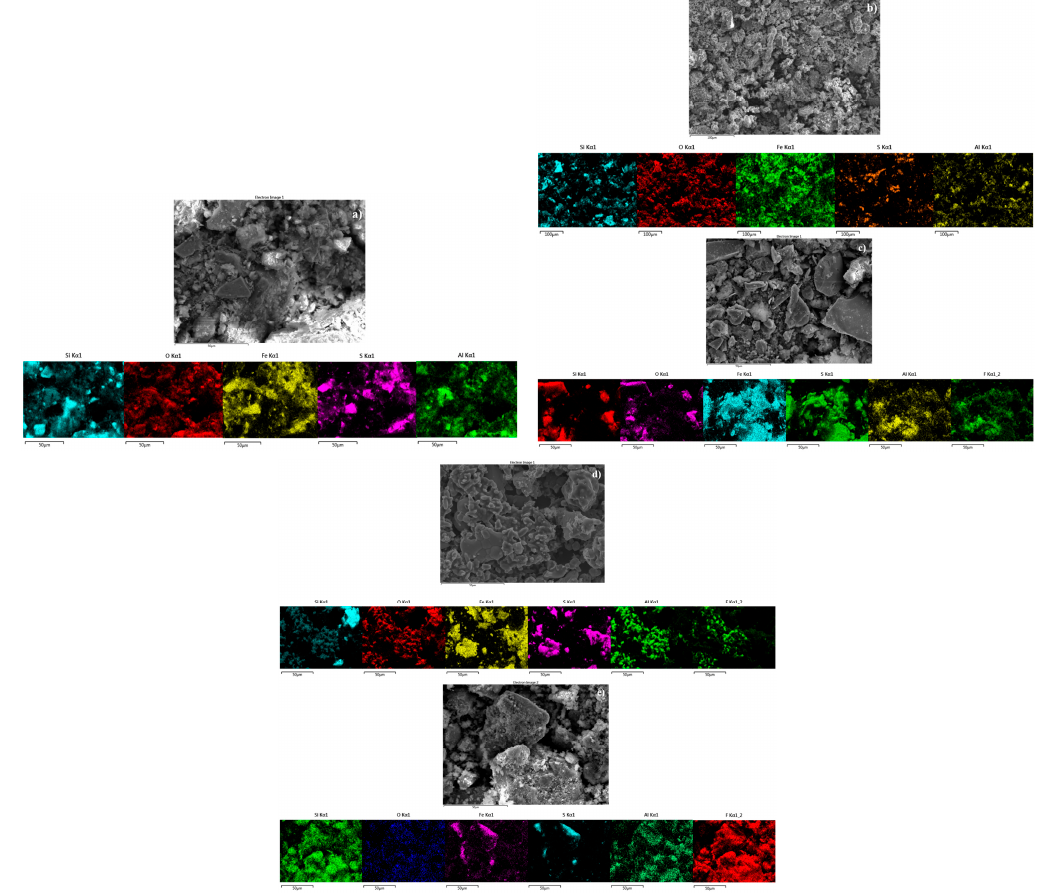
Figure 6. SEM images (50-100 µm) and EDS mapping of ( a ) raw, ( b ) roasted raw, ( c ) leached, ( d ) roasted leached, ( e ) slag tailings. Table 4. The semi-quantitative average elemental compositions extracted from EDS Map spectrum.